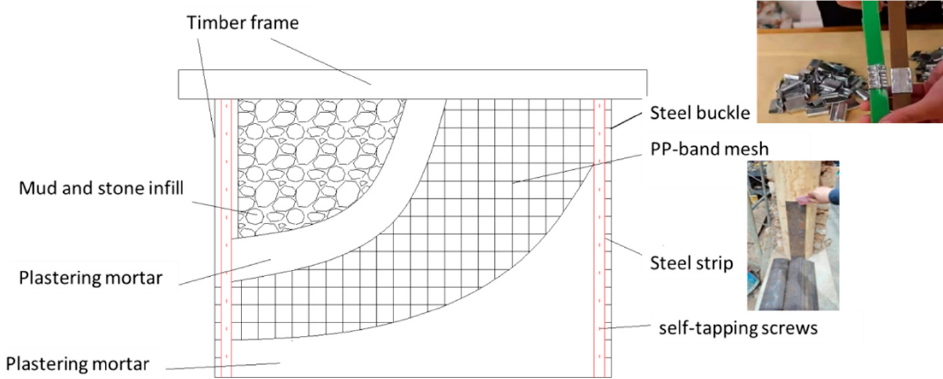
Figure 3. The proposed reinforcement method for the hybrid structure.